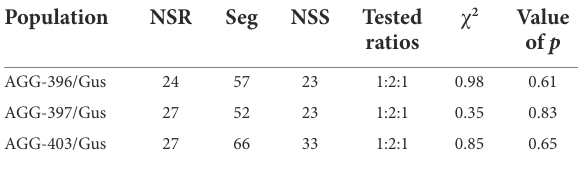
TABLE 4 Infection types produced by AGG-396, AGG-397, and AGG- 403 when tested against eight Puccinia hordei pathotypes in the greenhouse.